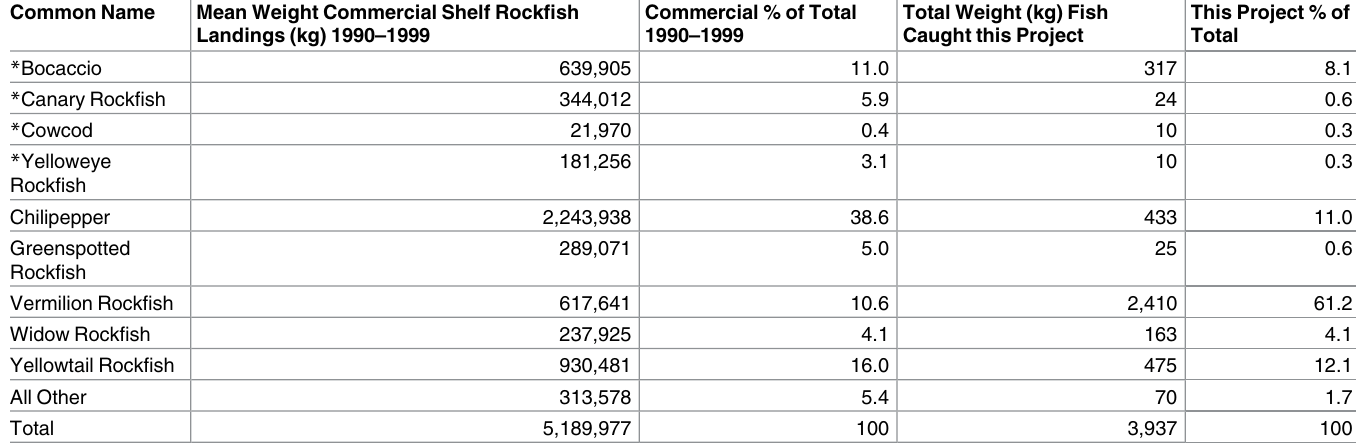
Table 5. Percentage of weight (kg per species) landed by commercialhook-and-line fisheries in central California from 1990–1999 [30] compared with percentages of species weights caught using experimental fishing gear